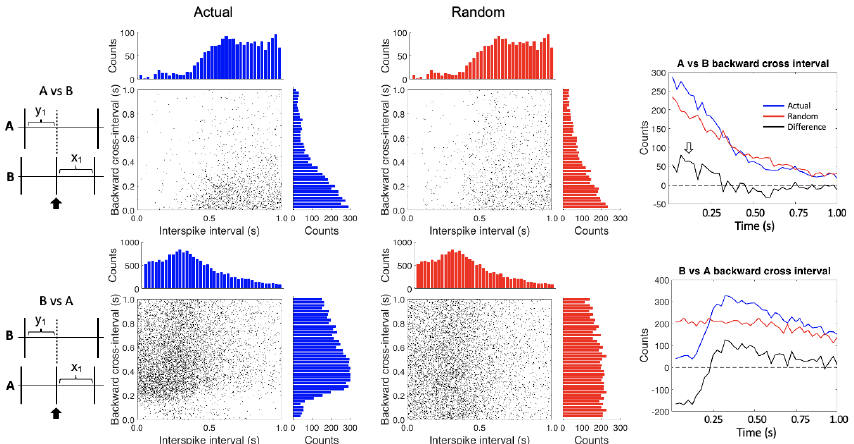
Figure 3. Conditional interspike interval plots. In the upper plots, the A spikes are referenced against the B spikes while the reverse is shown in the lower plots. The left hand (blue) plots show the actual data while the right hand (red) plots were created after randomizing the interspike intervals for each of the spike trains. The histograms on the tops and the sides of the plots show the counts by time bin for each axis–essentially compressing the x-y axes on their respective axis. The two graphs on the right show the differences (black lines) between the actual (blue lines) and randomized data (red lines) for the backward cross intervals. The open white arrow highlights the area of increased activity in the difference plot of the A vs. B backward cross-interval graph.